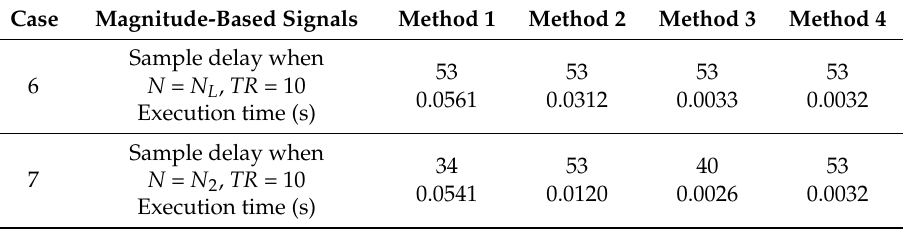
Table 3. Estimated sample delay and program execution time for a vehicle that traveled at 33.3 km/h.